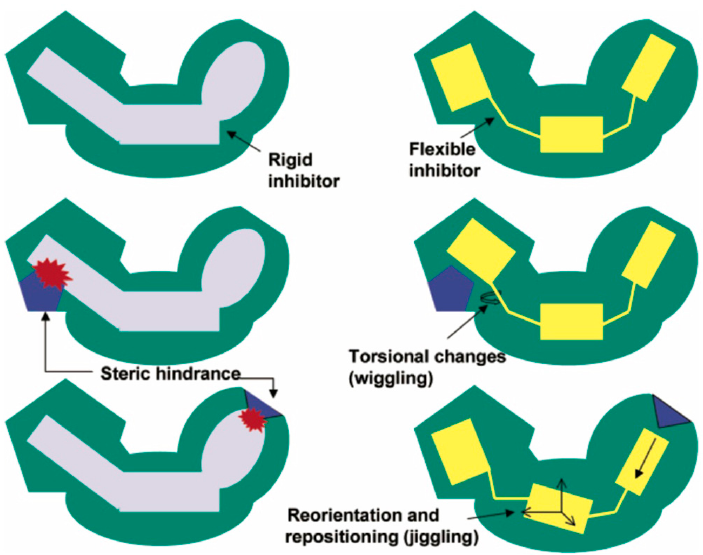
Figure 4. Strategic flexibility. This schematic diagram depicts how a flexible inhibitor can adjust its conformation and position, making it more effective than a rigid inhibitor at overcoming steric hindrance from a resistance mutation at the inhibitor-binding site. Reprinted with permission from Das et al. J. Med. Chem. 47:2550–2560 © 2004 American Chemical Society · [44].